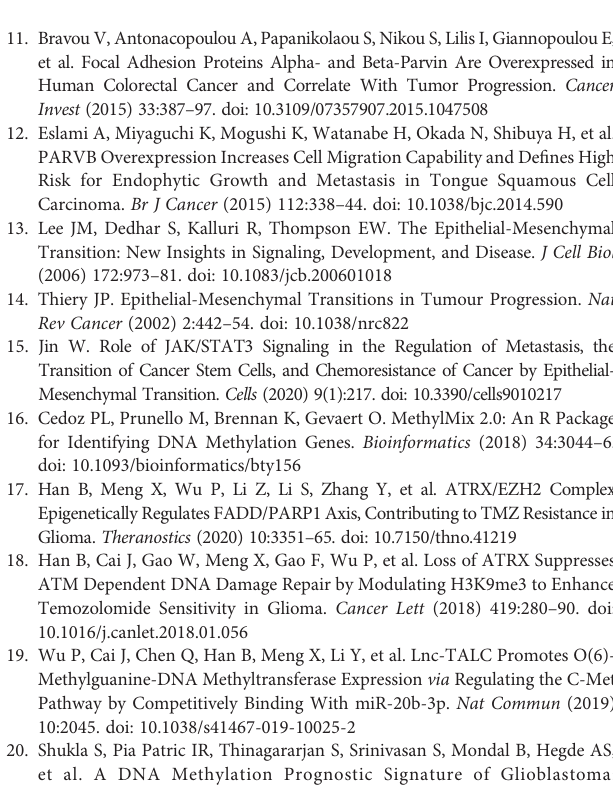
Supplementary Figure 1 | Expression heatmap of 72 DMDGs in GBM. Expression patterns of 72 DMDGs. Red represents upregulated genes and blue represents downregulated genes between GBM and normal tissues. Supplementary Figure 2 | Validation of DMDGs prognostic model in TCGA LGG set (n=458). (A) The expression pattern of DMDGs prognostic signature in low and high-risk groups; (B, C) Survival status and risk score analysis of DMDGs prognostic signature; (D) Survival analysis of DMDGs prognostic signature; (E) The ROC curve analysis within 1-, 2-, 3- and 5-year. Supplementary Figure 3 | Joint survival analysis and Assessment of migration and invasion independent of proliferation. (A – E) The hypermethylation low expression genes (MDK, SERPINB1, NMNAT3, PARVB and UPP1) have a signi fi cantly better OS than the hypomethylation high expression gene. (F, G) Ara-C (cytarabine, 3 m g/mL) was used to inhibit cell proliferation, and similar results of migration and invasion was observed in LN229 and HG7 cells. The assays were determined from three independent experiments, quanti fi cation data are expressed as average ± SD. Signi fi cant results are presented as *p < 0.05 and **p < 0.01. Supplementary Figure 4 | Assessment of migration independent of proliferation. Ara-C (cytarabine, 3 m g/mL) was used to inhibit cell proliferation, and similar results of migration was observed in LN229 and HG7 cells. The assays were determined from three independent experiments, quanti fi cation data are expressed as average ± SD. Signi fi cant results are presented as ns (non-signi fi cant), *p < 0.05. Supplementary Table 1 | The antibody of western blot assays used in this study. Supplementary Table 2 | A total of 7006 DEGs were selected in GBM patients. Supplementary Table 3 | A total of 72 DMDGs were identi fi ed in GBM patients. Supplementary Table 4 | A total of 35 prognostically relevant DMDGs were used for prognostic model